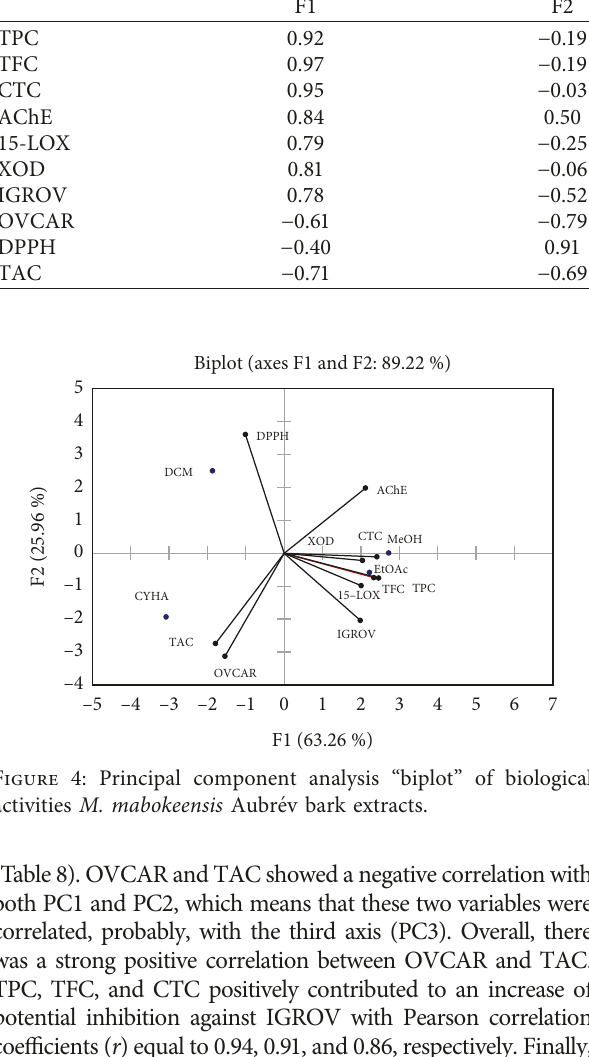
Table 8: Correlations between variables and factors. F1 F2